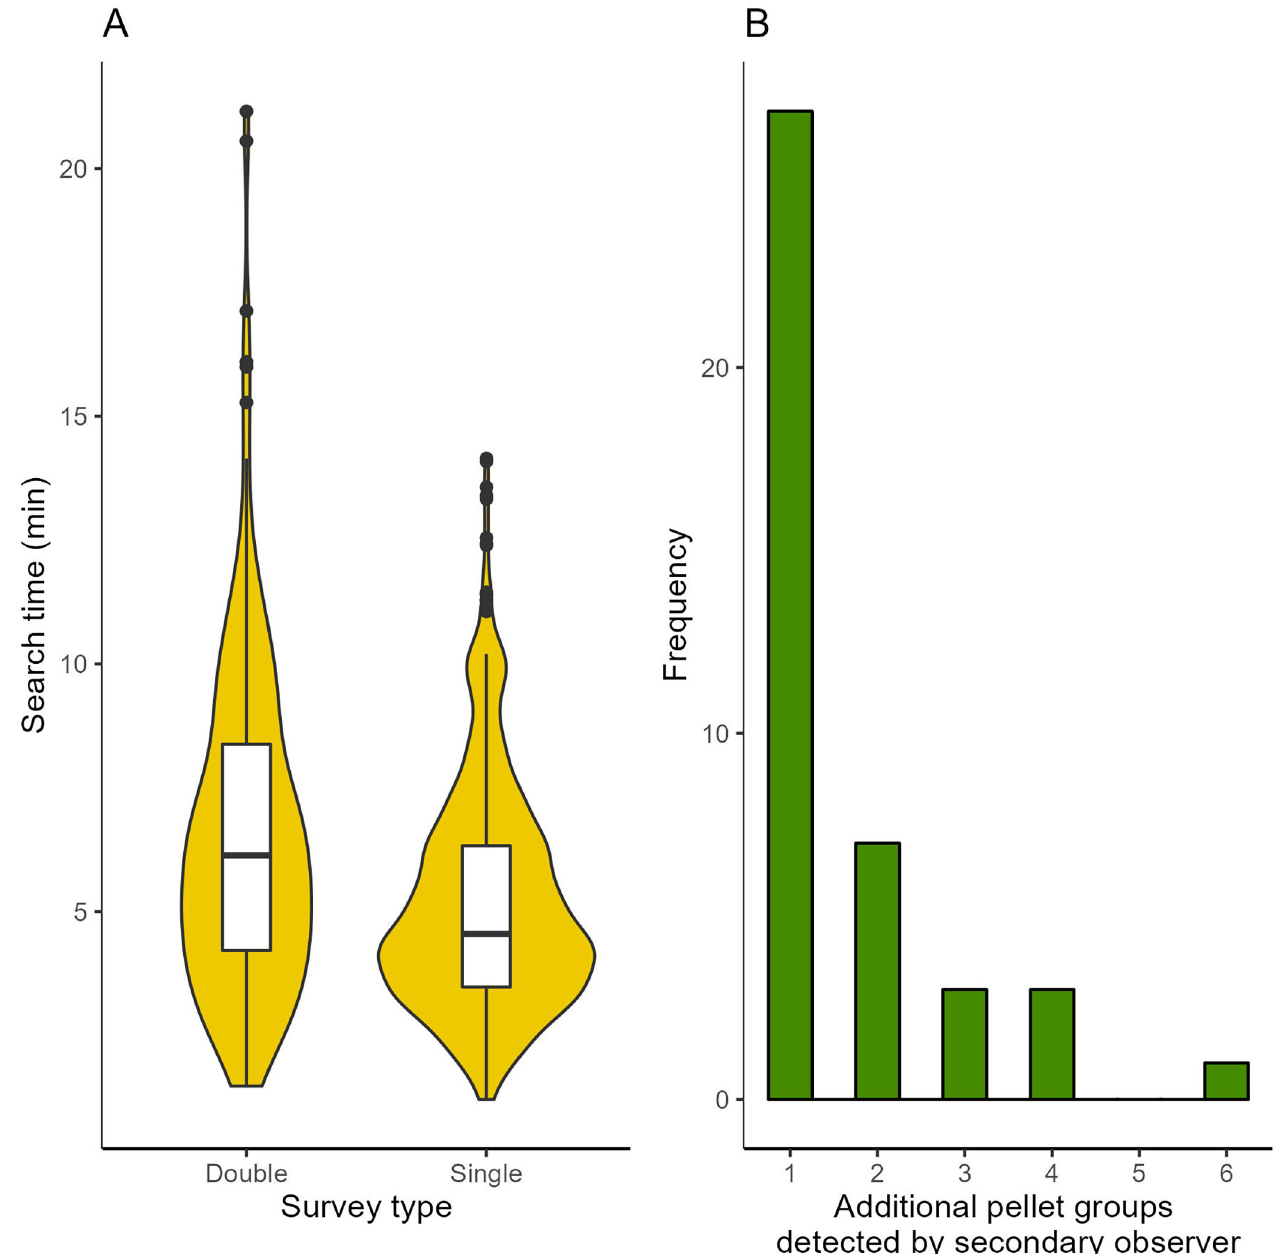
Fig 4. A) Box and violin plot of search time by survey type; B) distribution of additional pellet groups detected by the secondary observer. Surveys were conducted in Norway